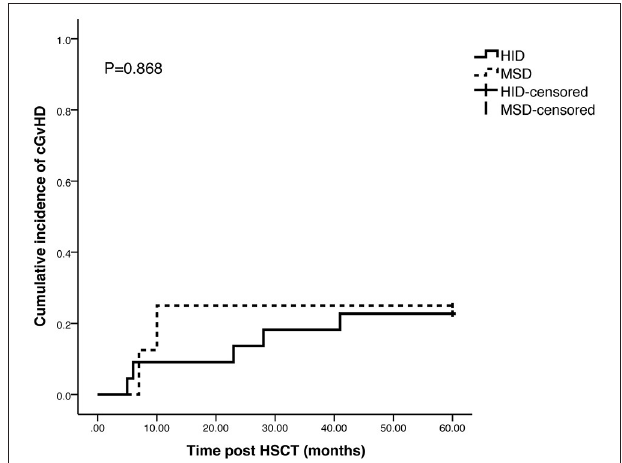
FIGURE 2 | Cumulative incidence of chronic GvHD (cGvHD) in HID cohort and MSD cohort.